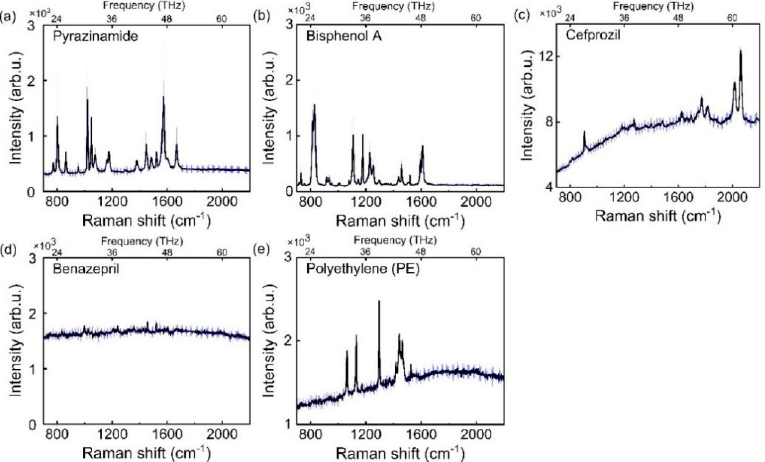
Figure 4. Raman spectra of four substances and PE (diluent): ( a ) pyrazinamide, ( b ) bisphenol A, ( c ) cefprozil, ( d ) benazepril, and ( e ) PE. The corresponding error bars have been labelled (blue color).